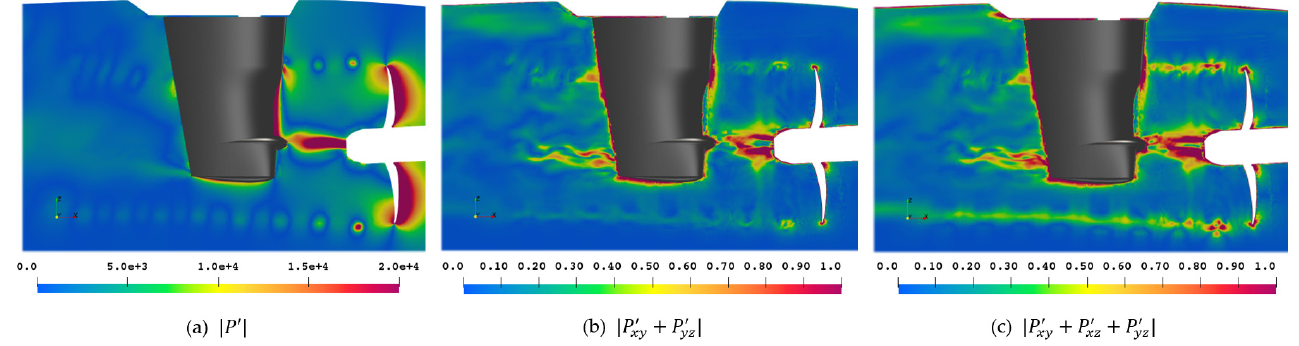
Figure 22. Perturbation stress tensor 𝑃′ (cid:3036)(cid:3037) magnitude ( a ) and magnitude of off-diagonal components ( b ), ( c ) on midplane in [Kg/ms (cid:2870) ].